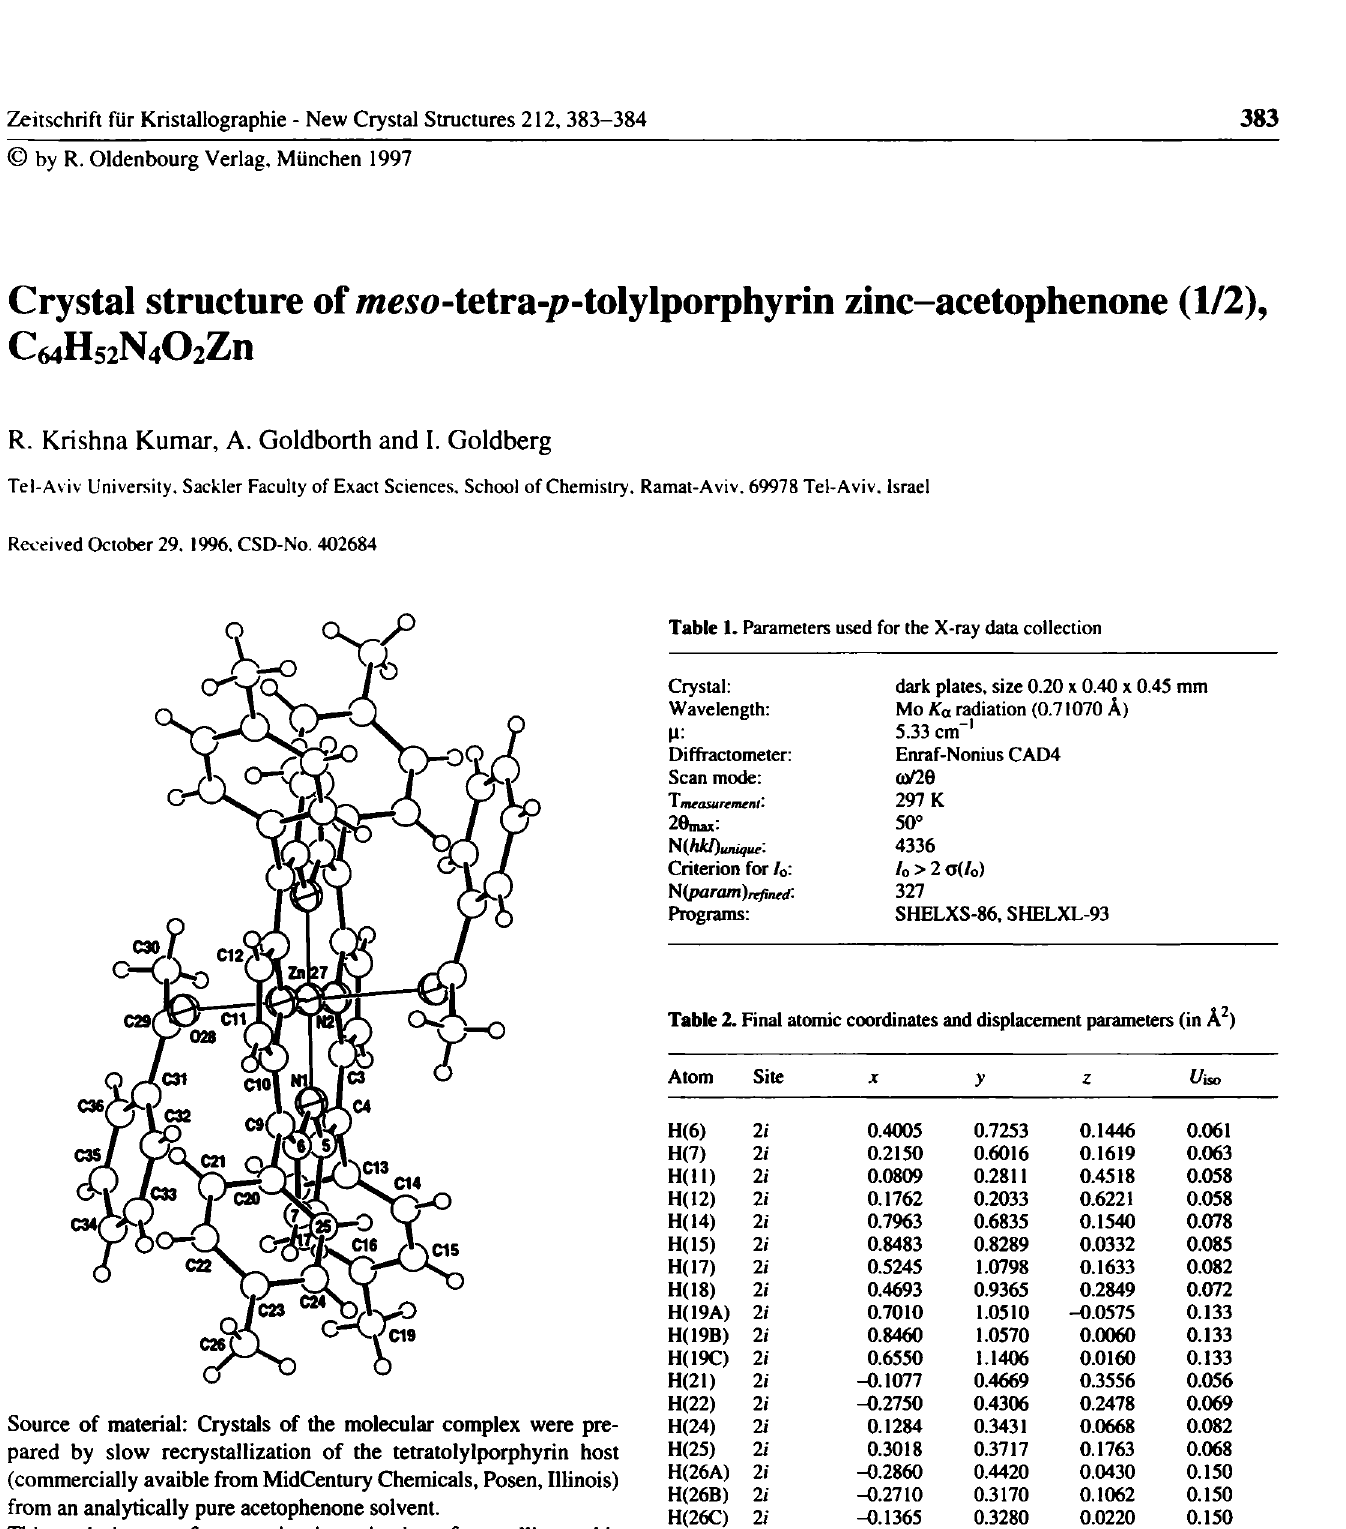
Table 2. Final atomic coordinates and displacement parameters (in Â 2